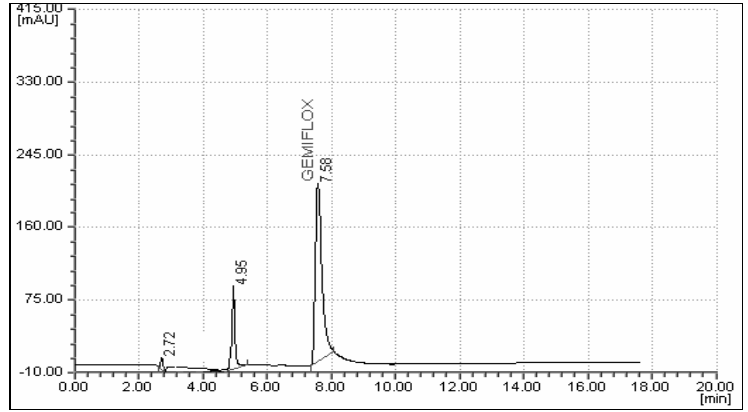
Figure 6. Chromatogram of gemifloxacin mesylate sample 2 (in tablet)